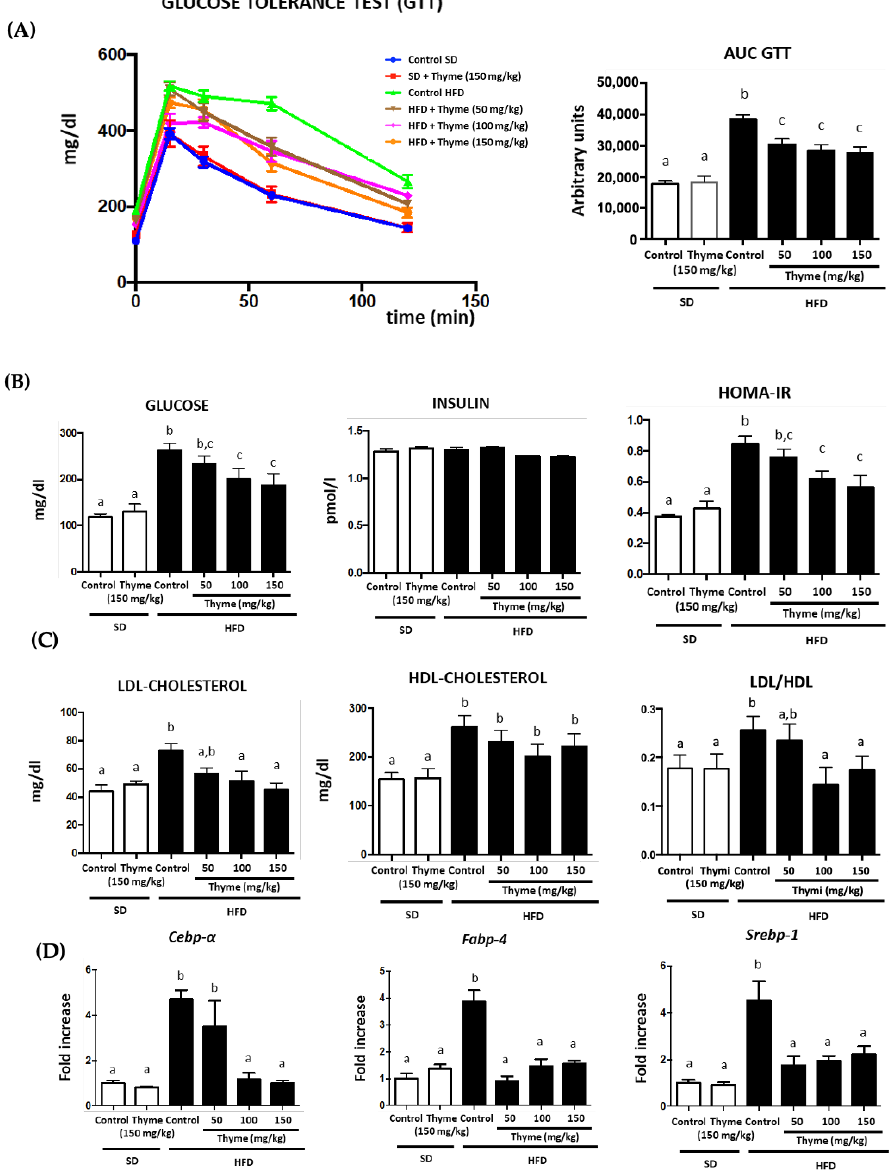
Figure 5. Effects of Thyme extract administration on: ( A ) glucose tolerance test (GTT), ( B ) plasma glucose and insulin levels, as well as on HOMA-IR ( C ) plasma LDL- and HDL-cholesterol levels, as well as on LDL/HDL ratio ( D ) expression of genes involved in adipogenesis in epididymal fat ( Cebp- α, Fabp -4 and Srebp1). Data are expressed as means ± SEM ( n = 10). Groups with different letters statistically differ ( p < 0.05).